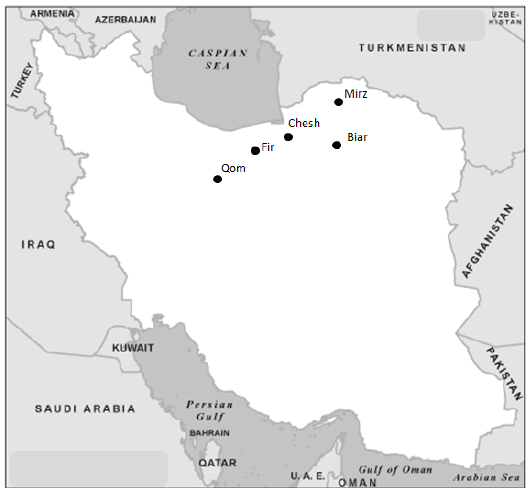
Fig. 1. Geographic distribution of five sampled populations of L. undulata Various factors, including leaf length and width, hair density on abaxial and adaxial leaf surfaces,